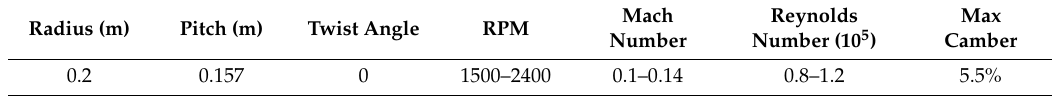
Figure 1. Propeller profile. Table 1. The characteristics of the propeller. RPM: Revolutions Per Minute